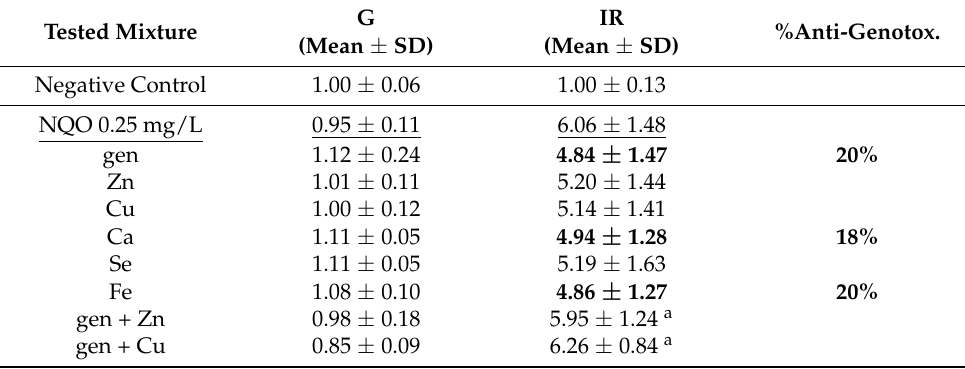
Table 2. Evaluation of anti-genotoxic activity based on G and IR values for the genotoxin—4NQO (4-nitroquinoline oxide) (0.25 mg/L, 0.05 mg/L)—and the mixture of NQO with genistein, minerals and their